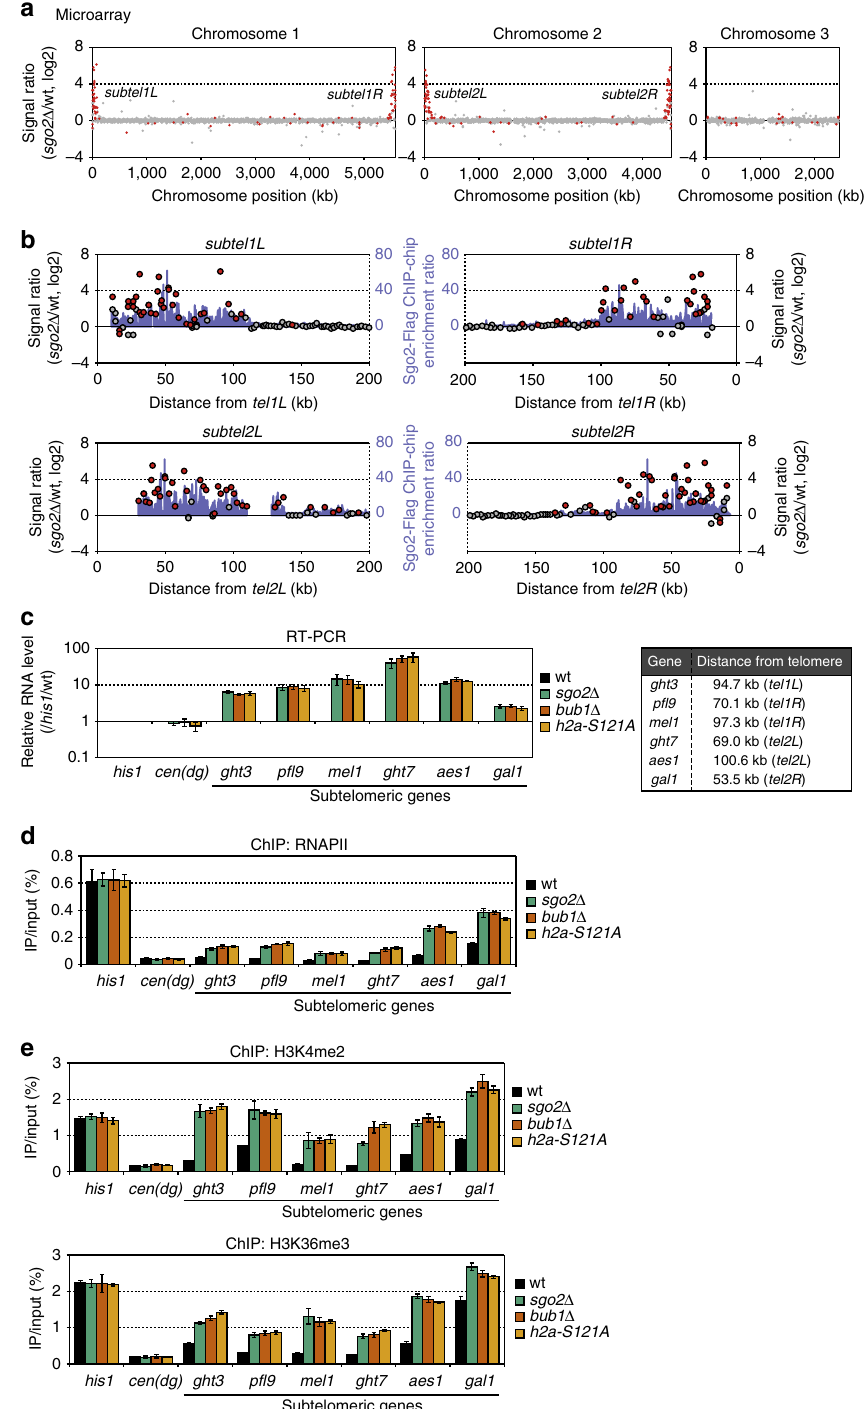
Figure 5 | Sgo2 represses transcription of the subtelomeric genes. ( a ) Microarray analysis of genome-wide changes in RNA expression caused by Sgo2 deletion. The signal ratio of each probe on the array is shown. Red dots and grey dots indicate significant ( P o 0.002 for an increase and P 4 0.998 for a decrease) and insignificant changes, respectively. The P -value was calculated as change P -value (two-sided) by Affymetrix GCOS1.4 with the default settings. ( b ) Magnified views of the subtelomeric regions in a . Localization of Sgo2 (from the ChIP–chip analyses) is indicated by the pale blue colour. ( c ) Association of Sgo2 with the subtelomeres is required for subtelomeric gene repression. The transcript levels of the subtelomeric genes and the centromeric repeats ( dg ) in wt, sgo2 D , bub1 D and h2a-S121A cells were analysed by quantitative reverse transcriptase–PCR (RT–PCR). The locations of the genes are shown in the box. Each value was normalized first to that of his1 þ and then to the wt value. ( d ) Occupancy of RNAPII at the subtelomeric gene loci is increased in sgo2 D , bub1 D and h2a-S121A cells. ChIP analyses of RNAPII at the subtelomeric gene loci and at the centromeric repeats ( dg ) are shown. The recovery of immunoprecipitated DNA relative to total input DNA was determined by quantitative PCR. ( e ) ChIP analyses of the levels of H3K4me2 (upper) and H3K36me3 (lower). The recovery of immunoprecipitated DNA relative to total input DNA was measured by quantitative PCR. Error bars indicate the s.d. ( n ¼